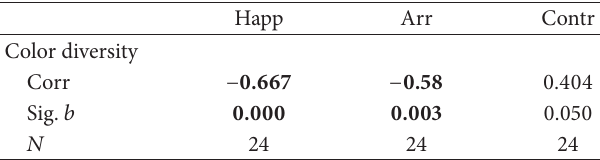
Table 4: Color number